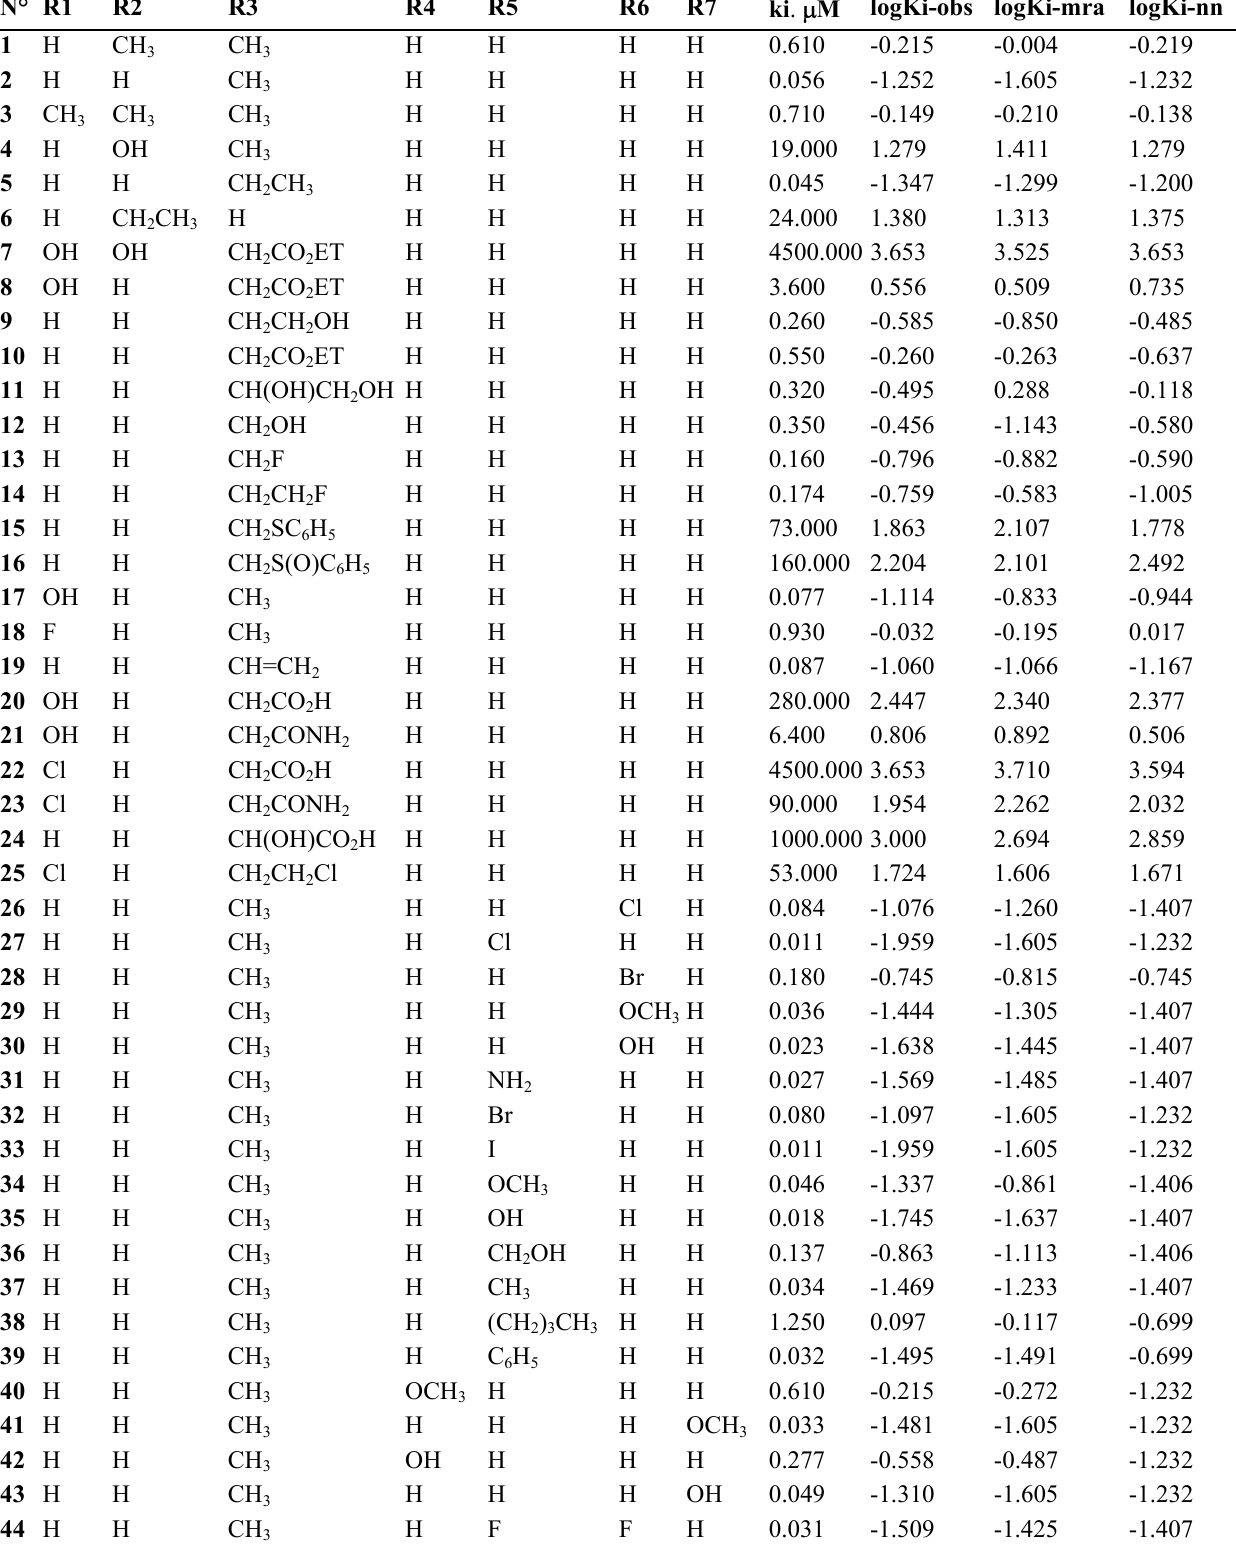
Table 1. The chemical structure of the studied compounds, the values of observed logKi (logKi-obs) corresponding to reference [4], and the values of predicted logKi (logKi-mra and logKi-nn) calculated using MRA and NN